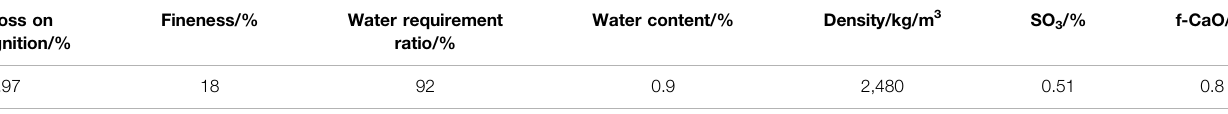
TABLE 3 | Physical and chemical performance indexes of fl y ash. Loss on ignition/%